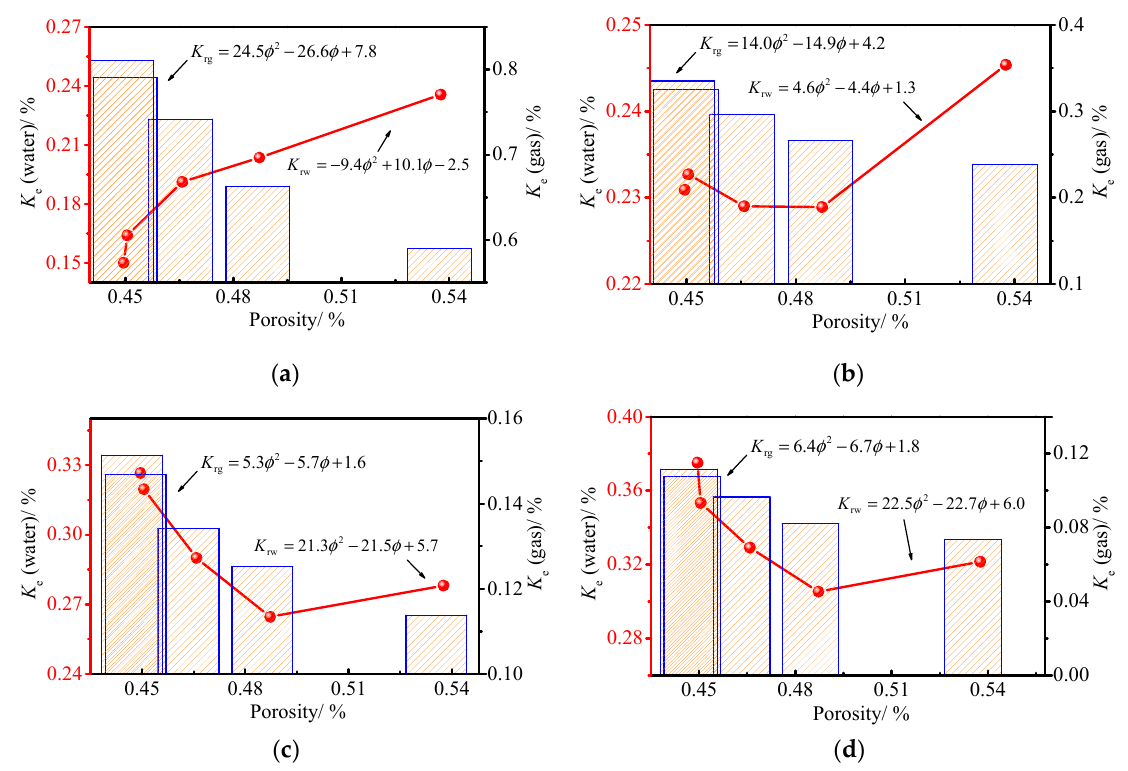
Figure 7. Effect of porosity on relative permeability. ( a ) The seepage pressure is 0.2 MPa; ( b ) the seepage pressure is 0.4 MPa; ( c ) the seepage pressure is 0.6 MPa; ( d ) the seepage pressure is 0.8 MPa.